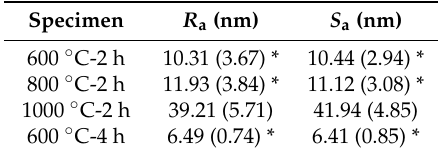
Table 2. Surface roughness ( S a and R a values) of specimens.